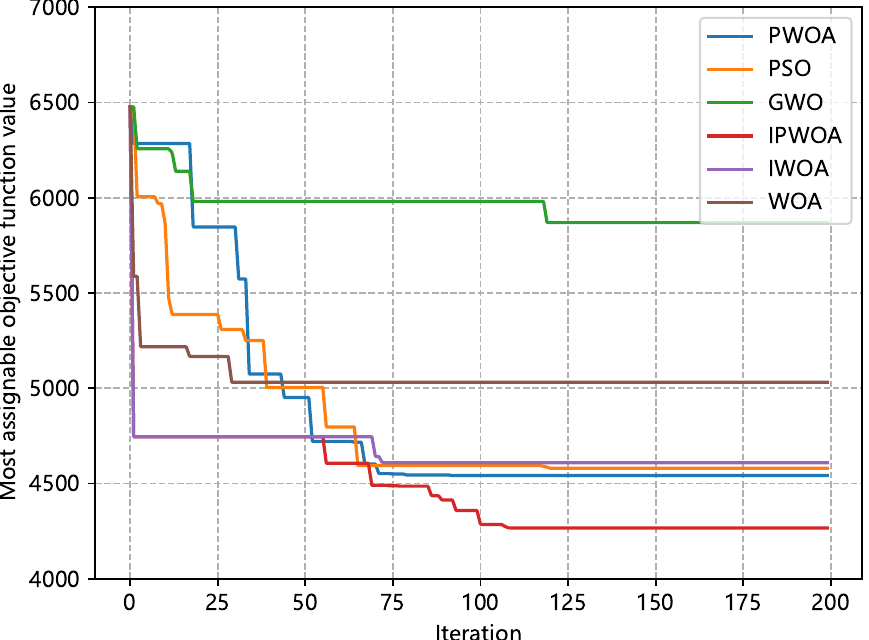
Figure 4. Optimized objective values after multiple iterations of different algorithms. Each algorithm iterates 200